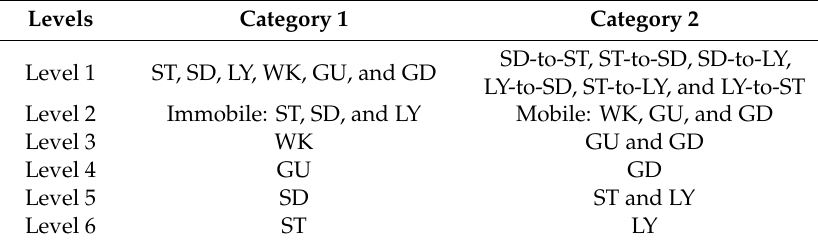
Table 5. Six levels of